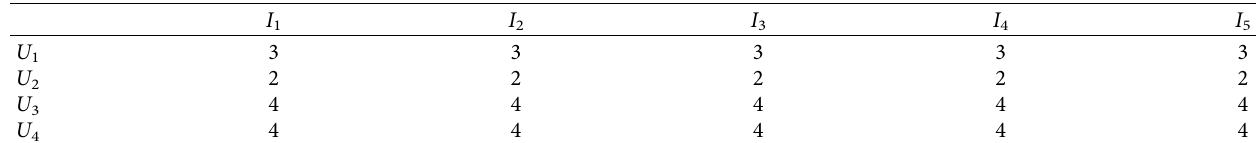
Table 1: User project rating